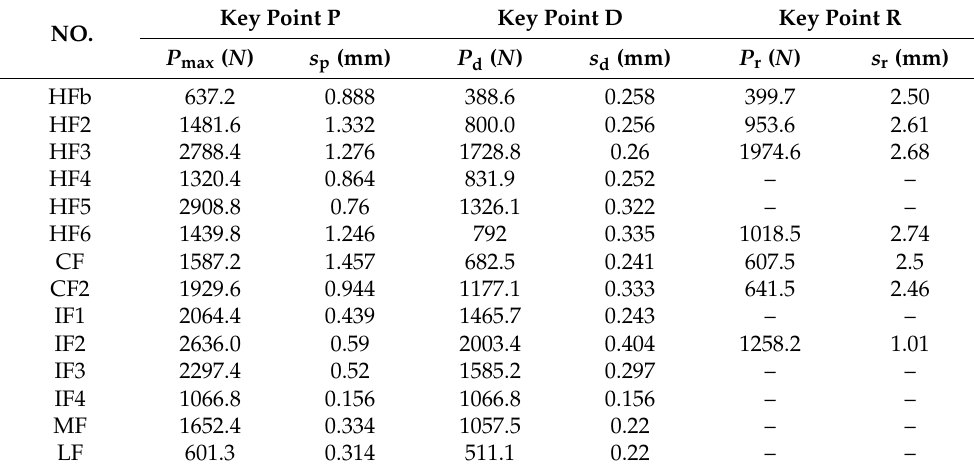
Table 5. Key points of pull-out load-slip